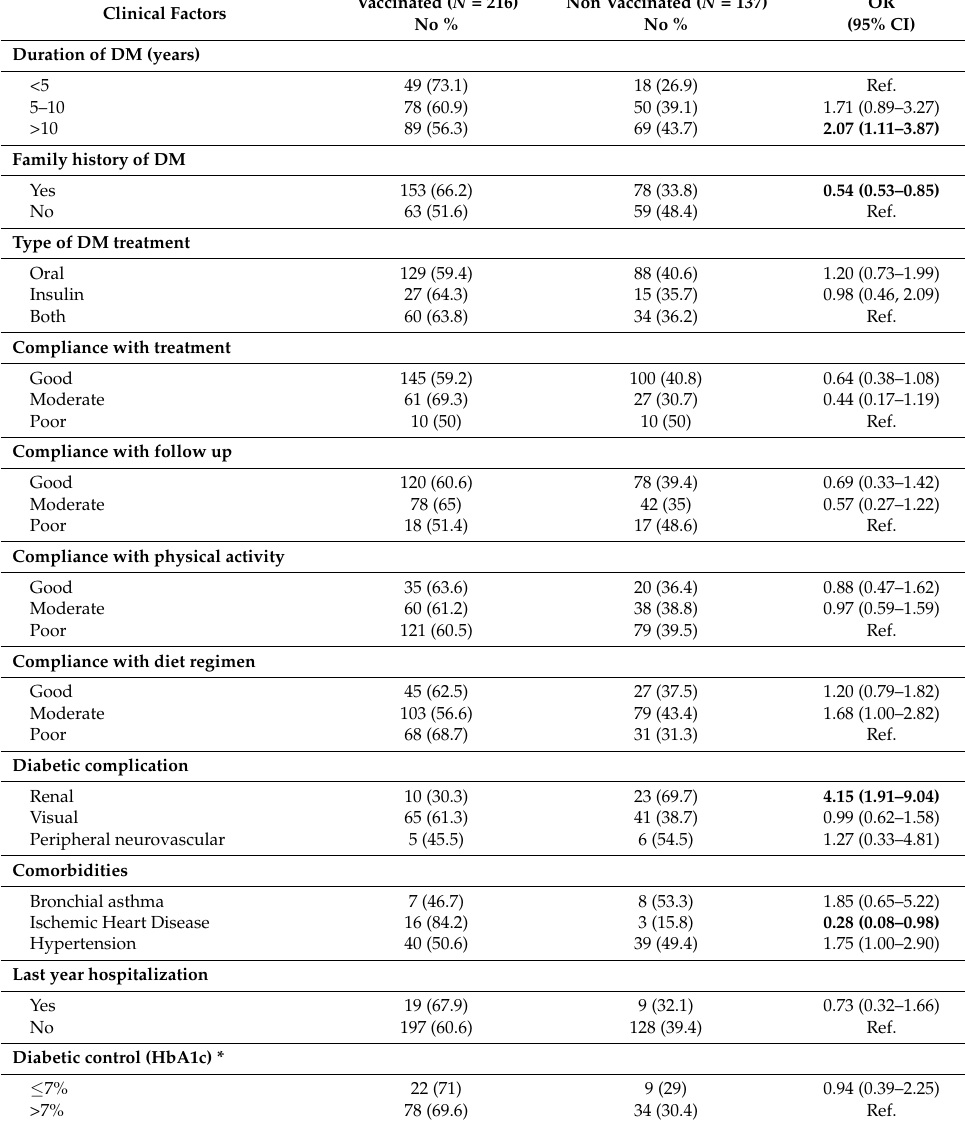
Table 4. Univariate analysis for clinical factors associated with seasonal influenza non-vaccination in the study T2DM patients ( N =